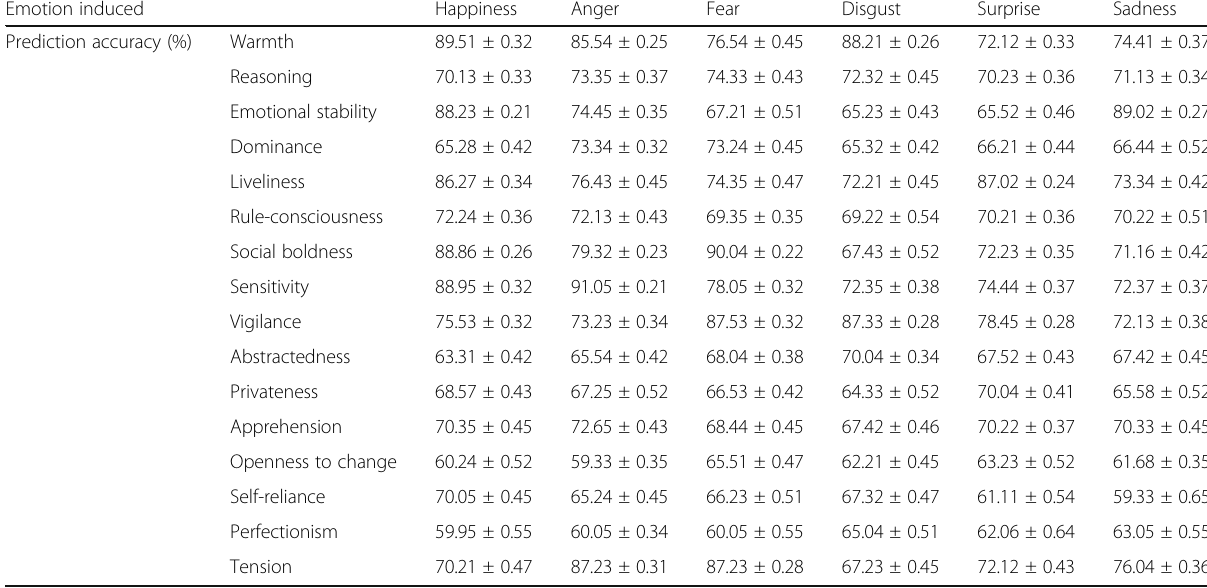
Table 3 16PF traits ’ prediction accuracy for intra-subject tests based on test sample induced emotion Emotion induced Happiness Anger Fear Disgust Surprise Sadness Prediction accuracy (%) Warmth 89.51 ±